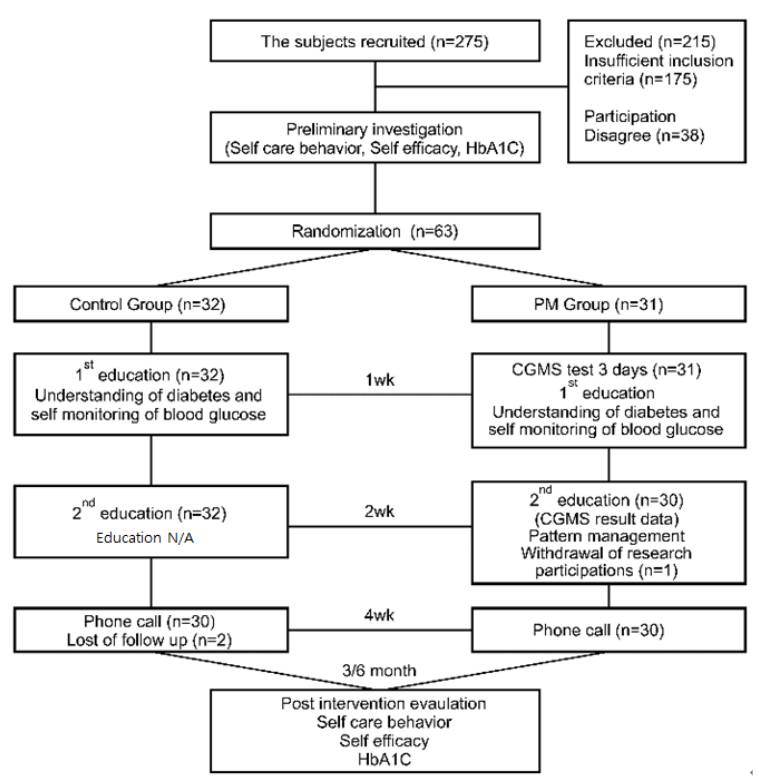
Figure 1. Study framework. CGMS, Continuous Glucose Monitoring System.